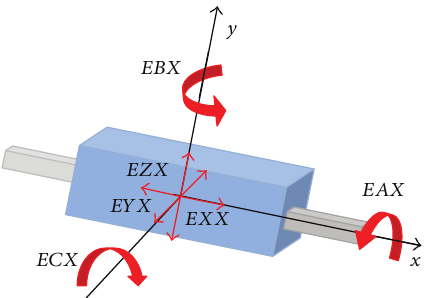
Figure 3: Errors of a linear axis. Movement direction 𝑋 .